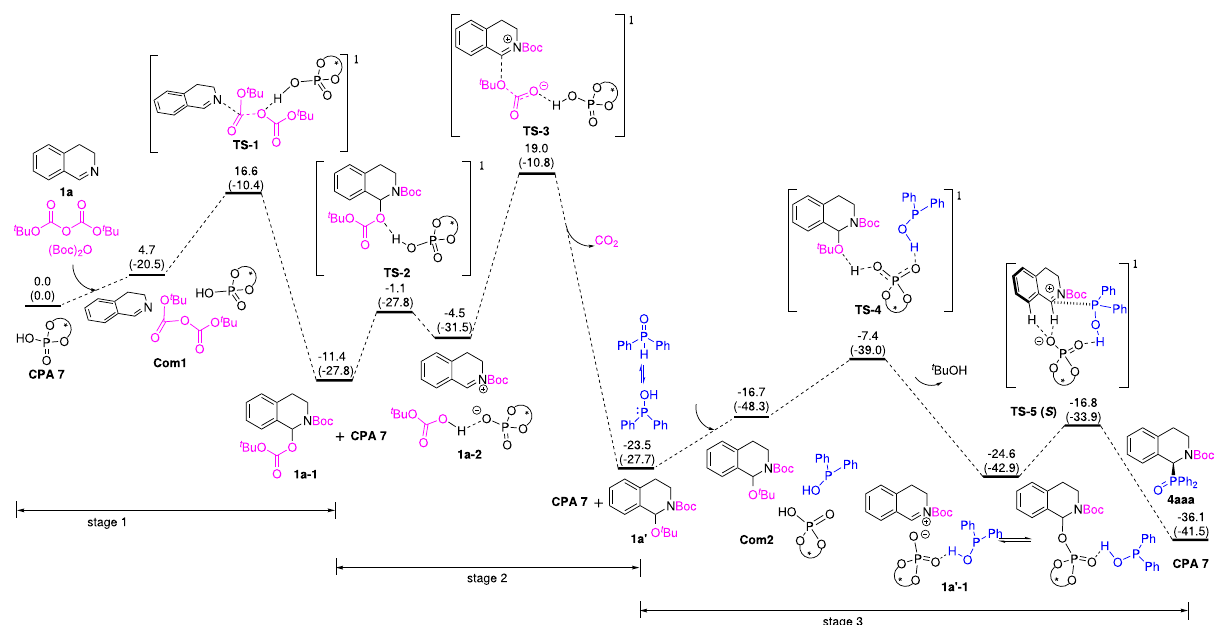
Fig. 6 Energy pro fi le calculated for the phosphoric acid catalyzed enantioselective phosphinylation of enantioselective phosphinylation of isoquinoline 1a. Relative free energies and electronic energies (in parentheses) are given in